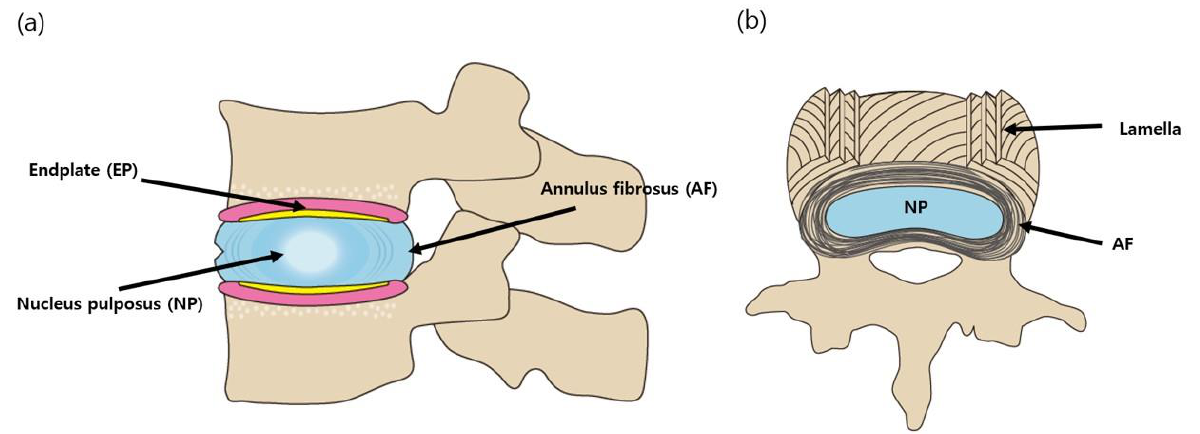
Figure 1. Schematic diagram of the intervertebral disc (IVD). ( a ) sagittal cross-section ( b ) axial cross-section. Depending on the stage of IVDD, different treatment strategies for managing IVDD have been recommended [14]. Initial IVDD shows change in the NP and AF matrices, while IVDD induces progressive structural changes such as annular fissures, disc herniation, disc height reduction, and disc space collapse. The Pfirrmann Disc Grading is a useful scoring tool for evaluating IVDD on MRI T2-weighted images; Grade I: homogeneous disc with bright high intensity and normal disc height; Grade II: inhomogeneous disc but high intensity signal, clear distinction between NP and AF, and normal disc height; Grade III: inhomogeneous disc with an intermittent gray signal intensity, unclear distinction between NP and AF, and normal or slightly reduced disc height; Grade IV: inhomogeneous disc with low intensity dark gray signal intensity, no more distinction between the NP and AF, and slightly or moderately decreased disc height; Grade V: inhomogeneous disc with a hypointense black signal intensity, no more distinction between the nucleus and annulus, and collapsed disc space [15]. For severe nerve compression due to herniated disc and disc space collapse (Pfirrmann grades IV and V), surgical removal of herniated